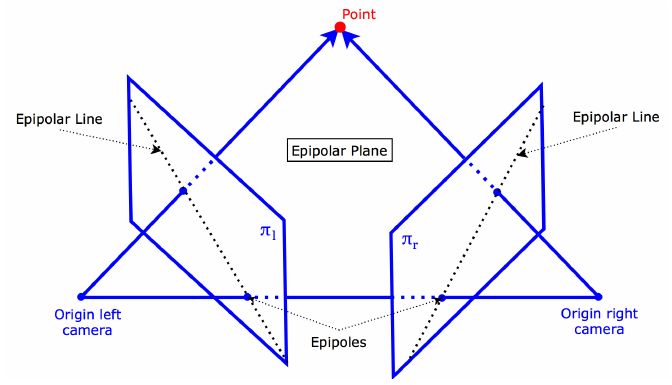
Figure 3. Epipolar